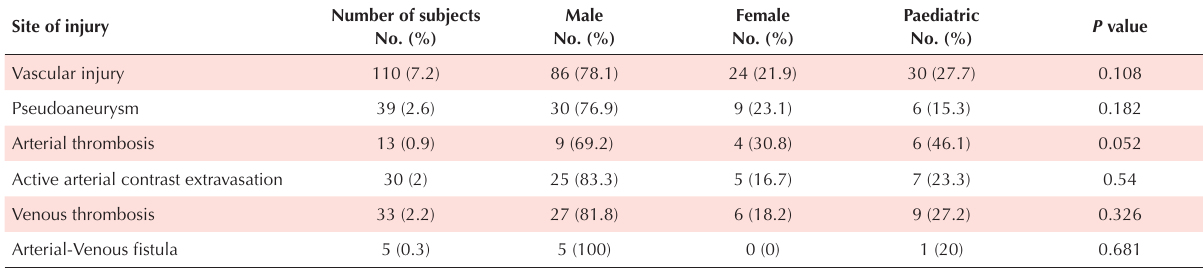
Table 3 . Pattern and distribution of the vascular injuries